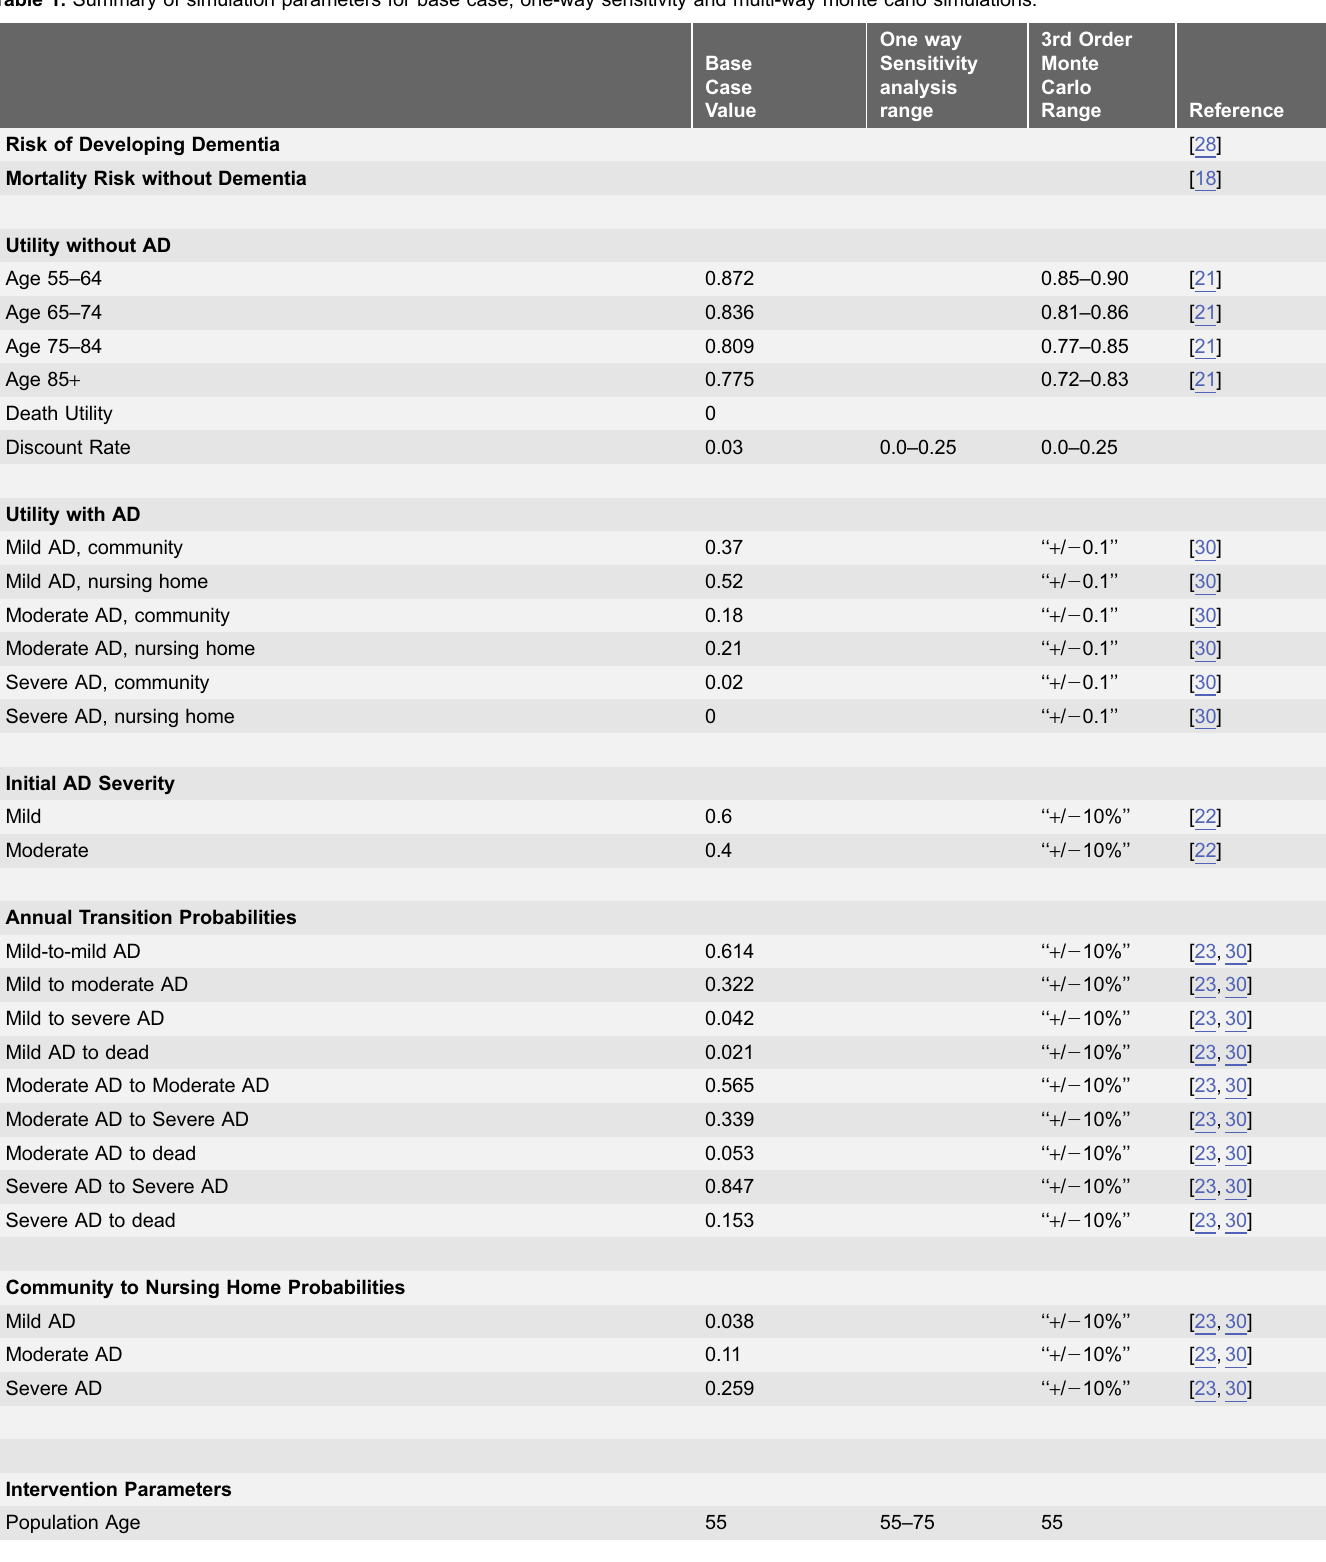
Table 1. Summary of simulation parameters for base case, one-way sensitivity and multi-way monte carlo